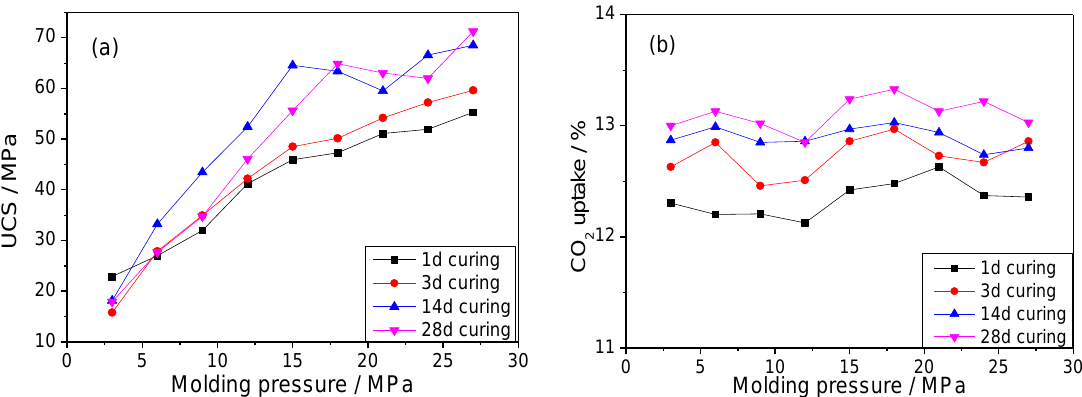
Figure 7. ( a ) UCS and ( b ) CO 2 uptake results of samples with different molding pressures. The CO 2 uptake of the samples cured for 1 day did not show a clear change with molding pressure. This result proves that high molding pressure (i.e., high density and low pore volume in the microstructure) almost did not block CO 2 from transferring from the air into the block’s core. In the experiment, when the molding pressure was 27 MPa or greater, water began squeezing out of the block, which meant that water saturation reached 100% at this point.